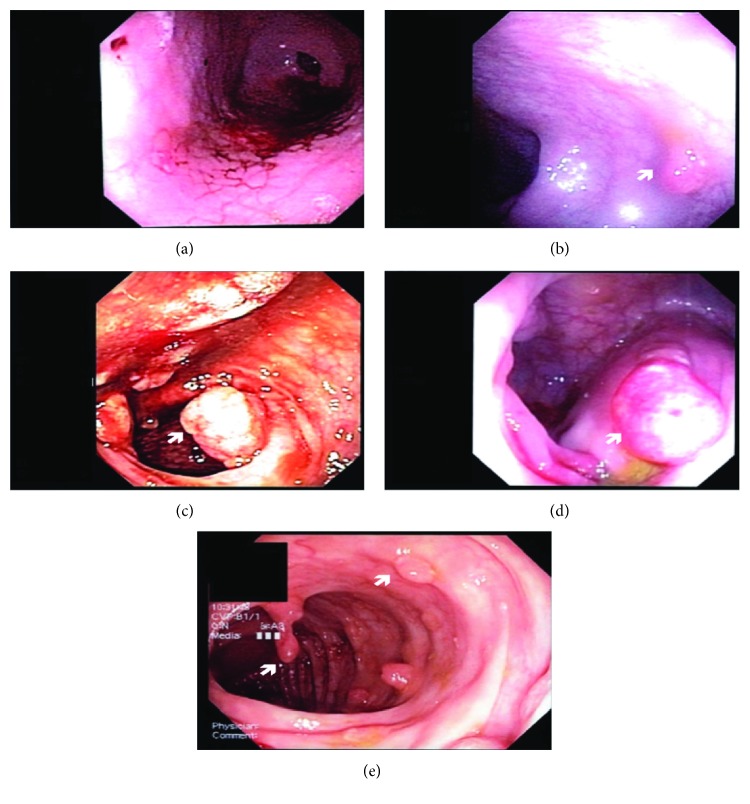
Endoscopy images of patient with antral nodularity (H. pylori gastritis) and extensive colonic polyposis (b)–(e).